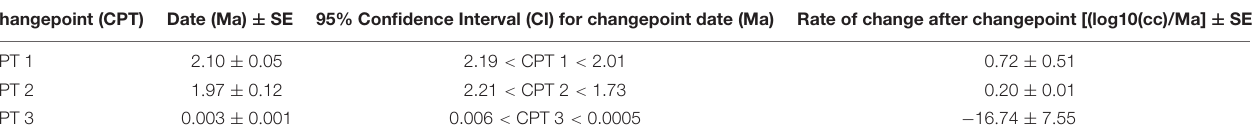
TABLE 2 | Estimates of changepoint dates—including small-brained Pleistocene Homo ( N =